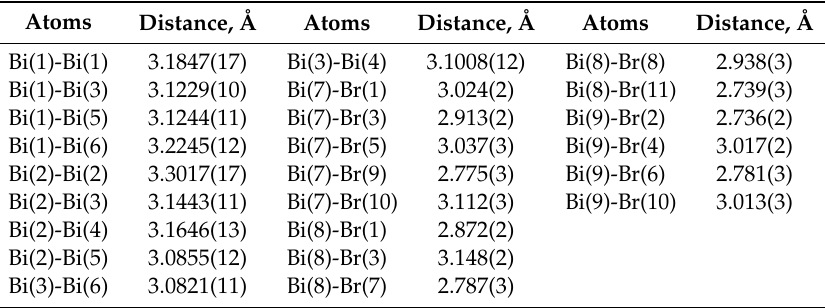
Table 1. Selected interatomic distances for Bi 6 Br 7